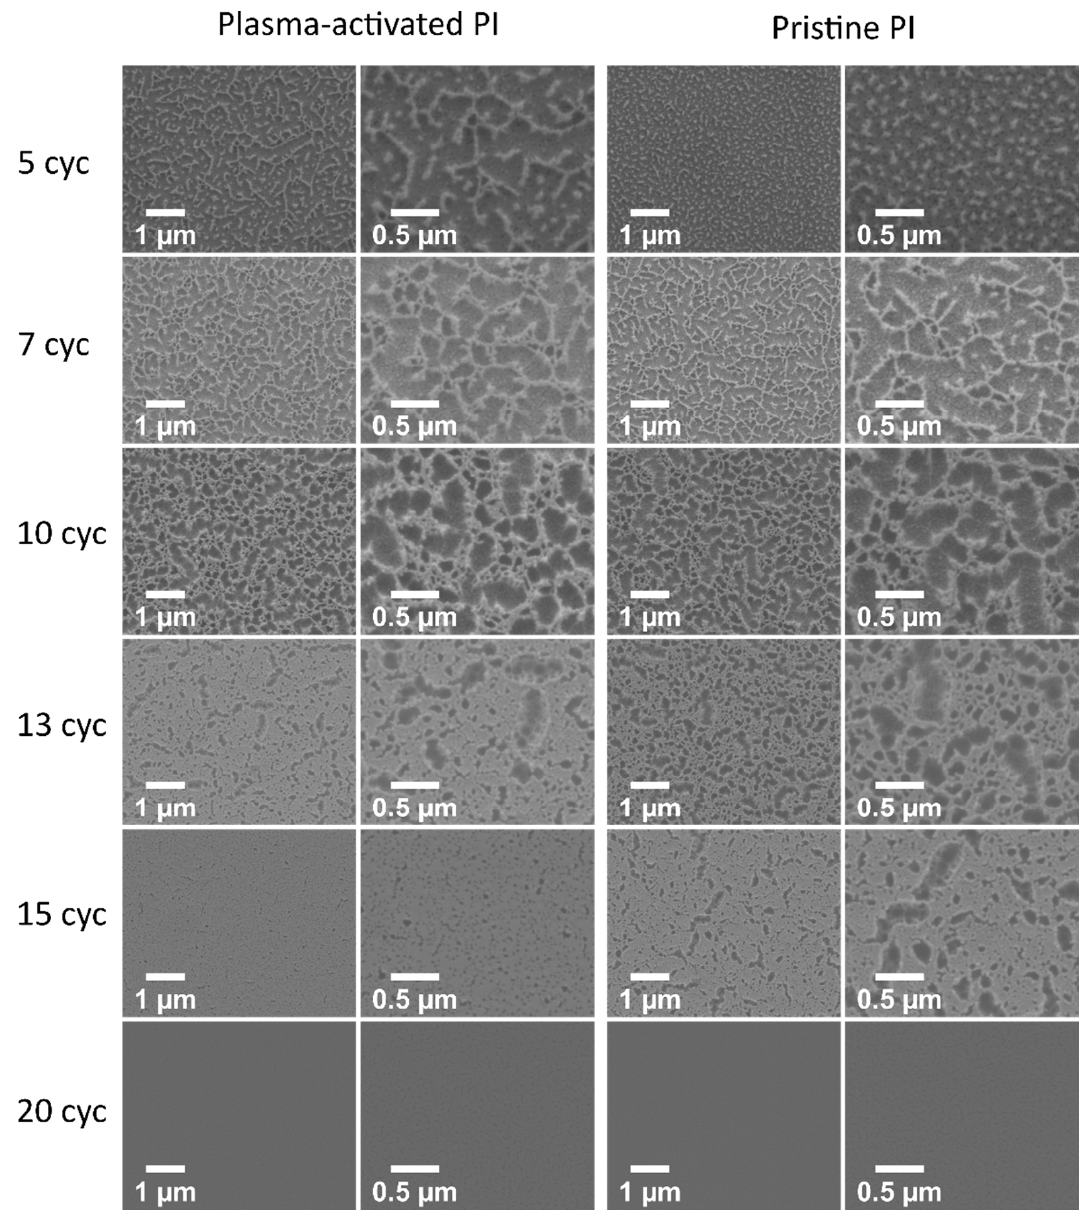
Figure 8. FEG–SEM images showing the evolution of HfO 2 ALD nucleation on plasma-activated polyimide and pristine polyimide.